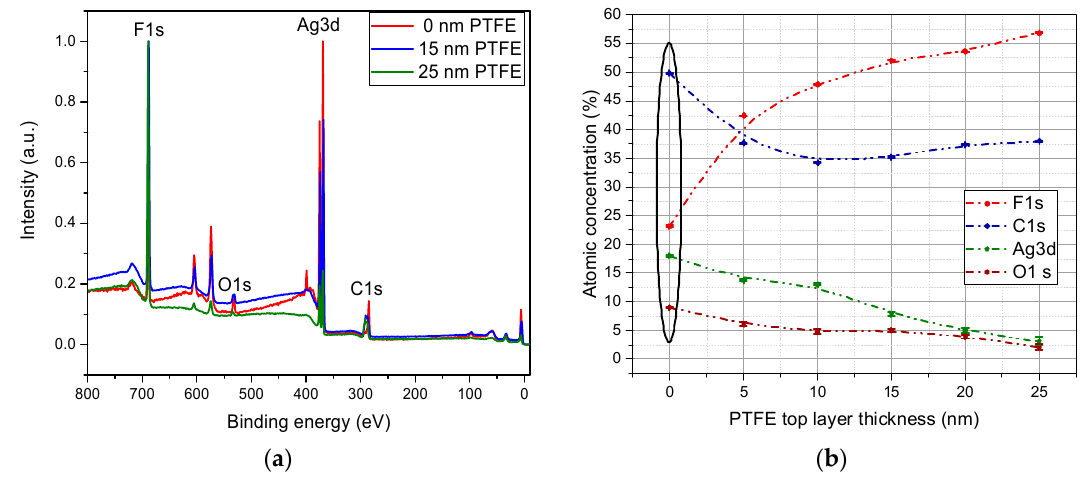
Figure 3. Survey spectra for PTFE / Ag / PTFE nanocomposites as a function of topcoat layer thickness ( a ) and the variation of the atomic concentration of the main elements regarding the thickness of the PTFE topcoat layer ( b ).